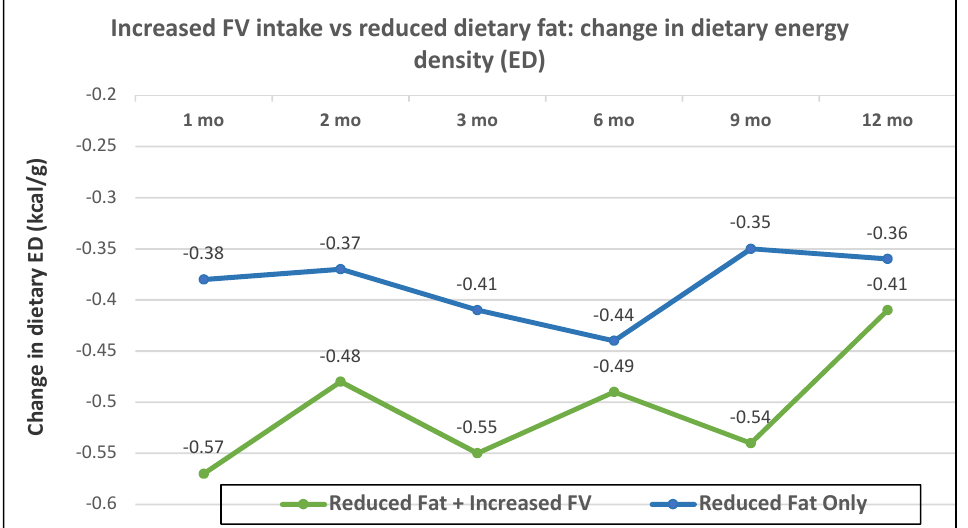
Figure 20. Mean change in dietary ED (kcal/g) from baseline for increased fruit and vegetables (FV) and reduced-fat vs. reduced-fat (control) over 12 months ( p = 0.019) [58]. Postmenopausal women—dietary approach # 4—adding low sodium vegetable juice to Dietary Approaches to Stop Hypertension (DASH) diet. A US RCT in 81 adults (73 women; mean age 50